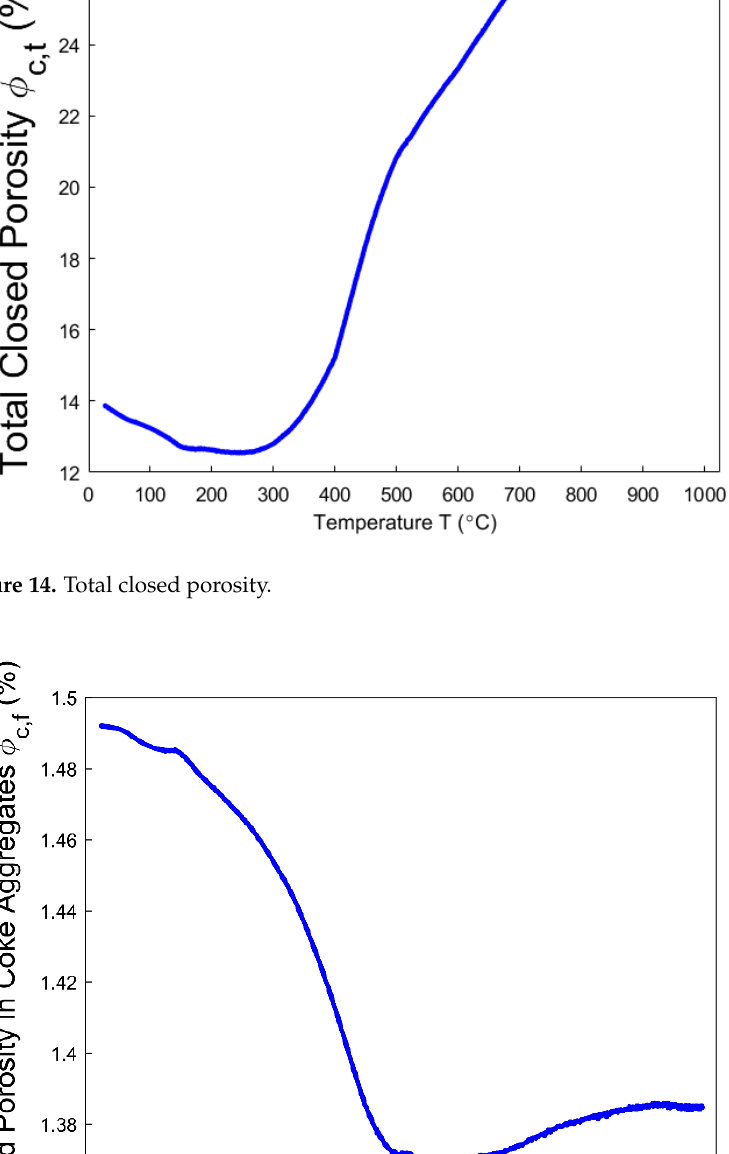
Figure 13. Open porosity.